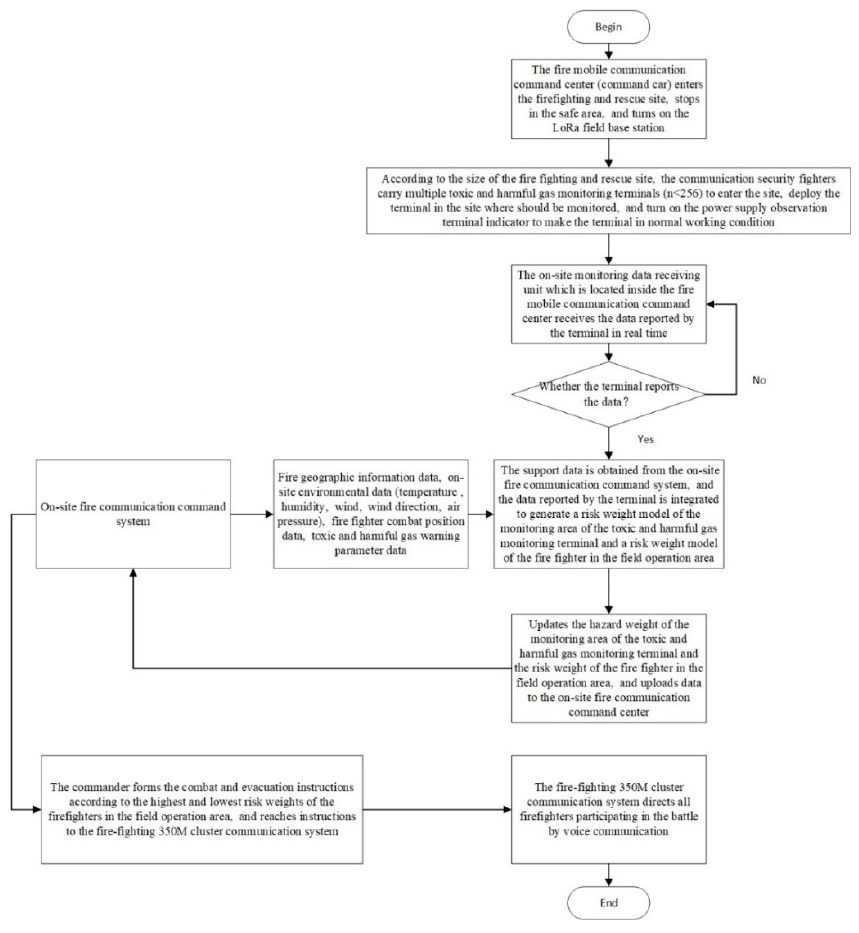
Figure 3. Data transmission processing flow chart.